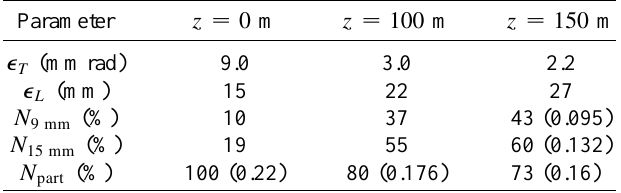
TABLE II. Evolution of beam parameters in the FOFO cooling channel. The number of muons per proton incident on target is shown in parentheses in the last three rows.